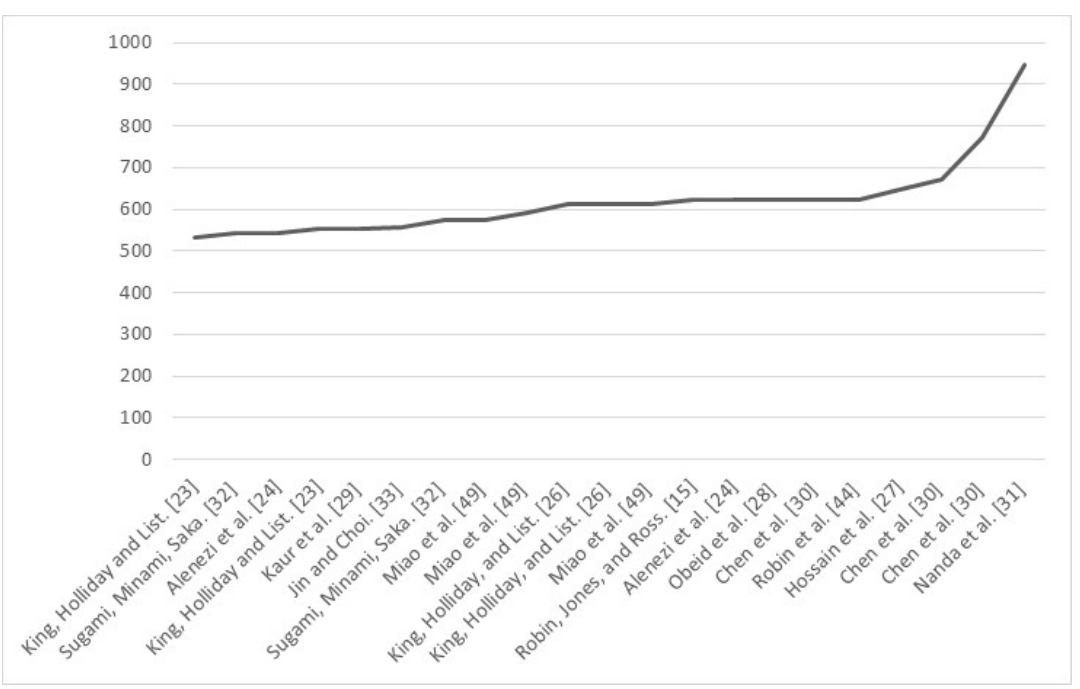
Figure 7. Temperatures (K) used in hydrothermal experiments with fatty acids.